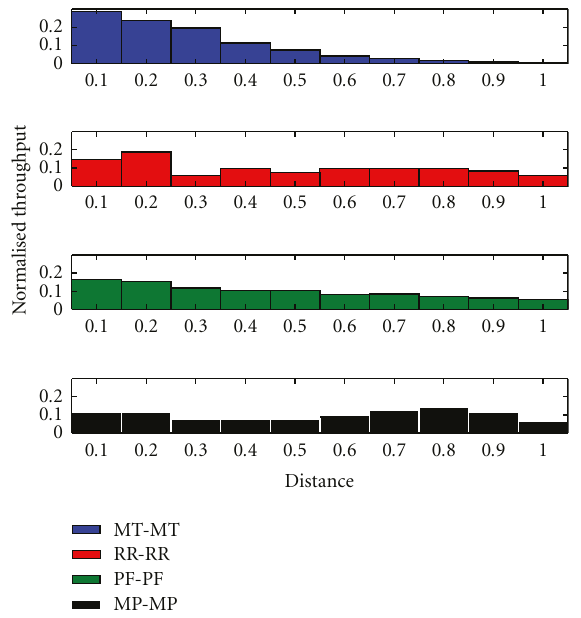
Figure 9: Normalized throughput distribution according to dis-